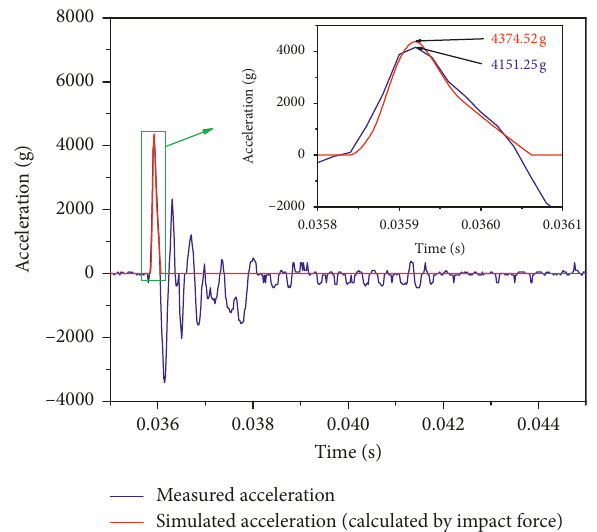
Figure 11: Comparison of the measured result and the simulation